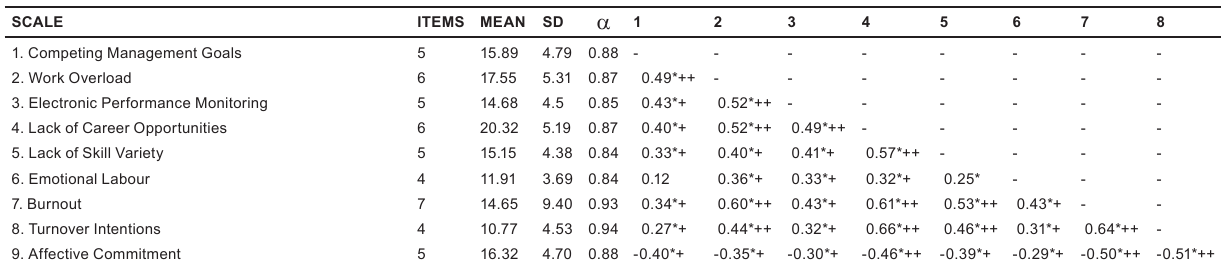
table 2 Descriptive statistics and product-moment correlations